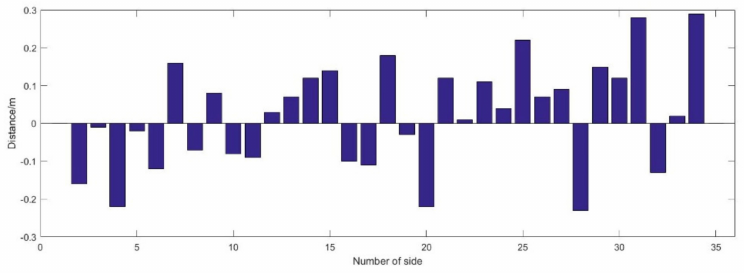
Figure 10. UWB ranging error.